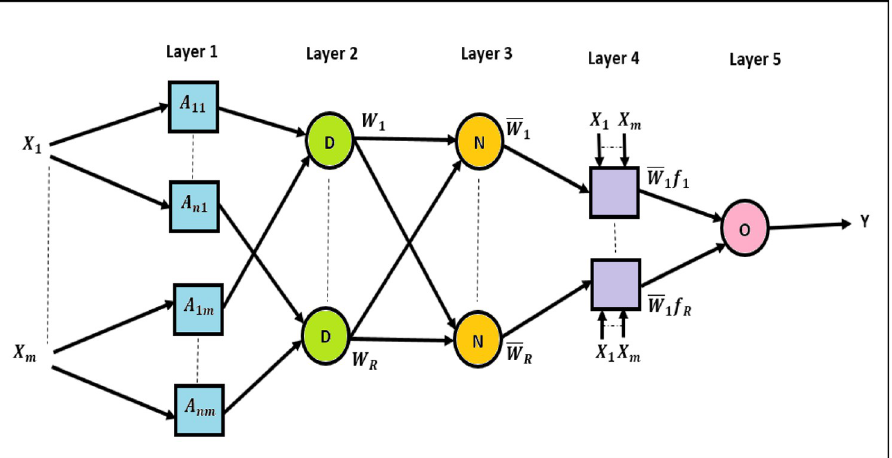
Fig 3. The workflow of MATLAB ANFIS